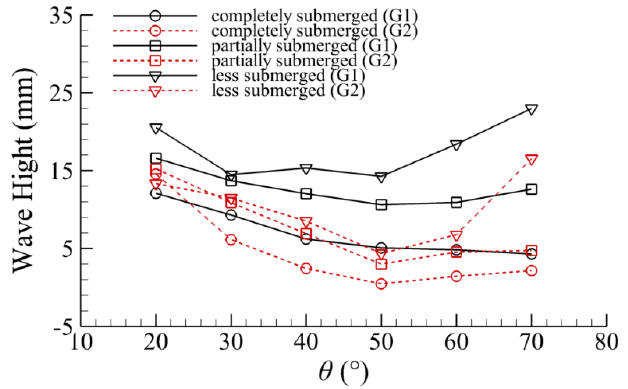
Figure 14. The change of maximum wave height with the falling angle.